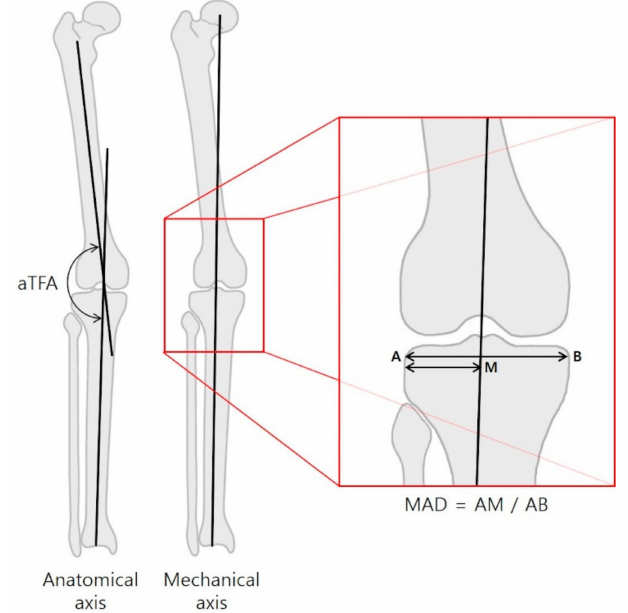
Figure 3. The anatomical tibiofemoral angle (aTFA) was measured on full-length standing radiographs. The mechanical axis deviation was expressed as a ratio of the distance of the axis from the lateral border of the tibia to the width of the tibial articular